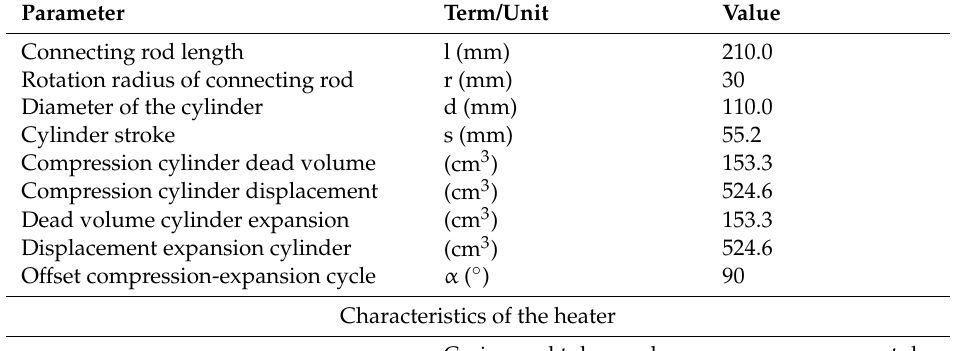
Table 1. Geometric characteristics of the GENOA 03